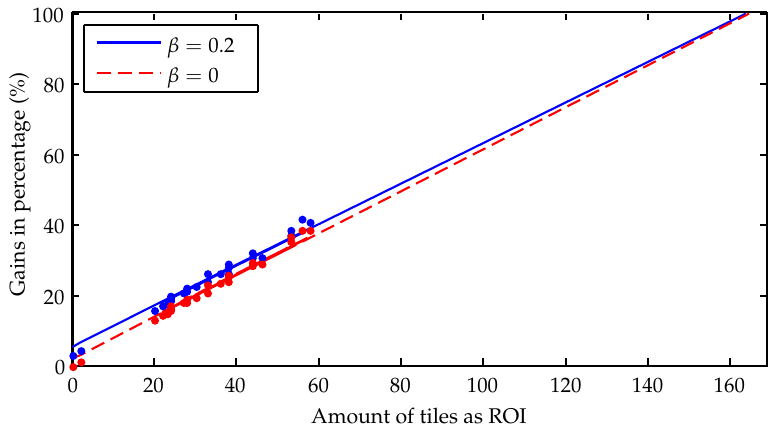
Figure 20. Percentage gains by number of tiles classified as